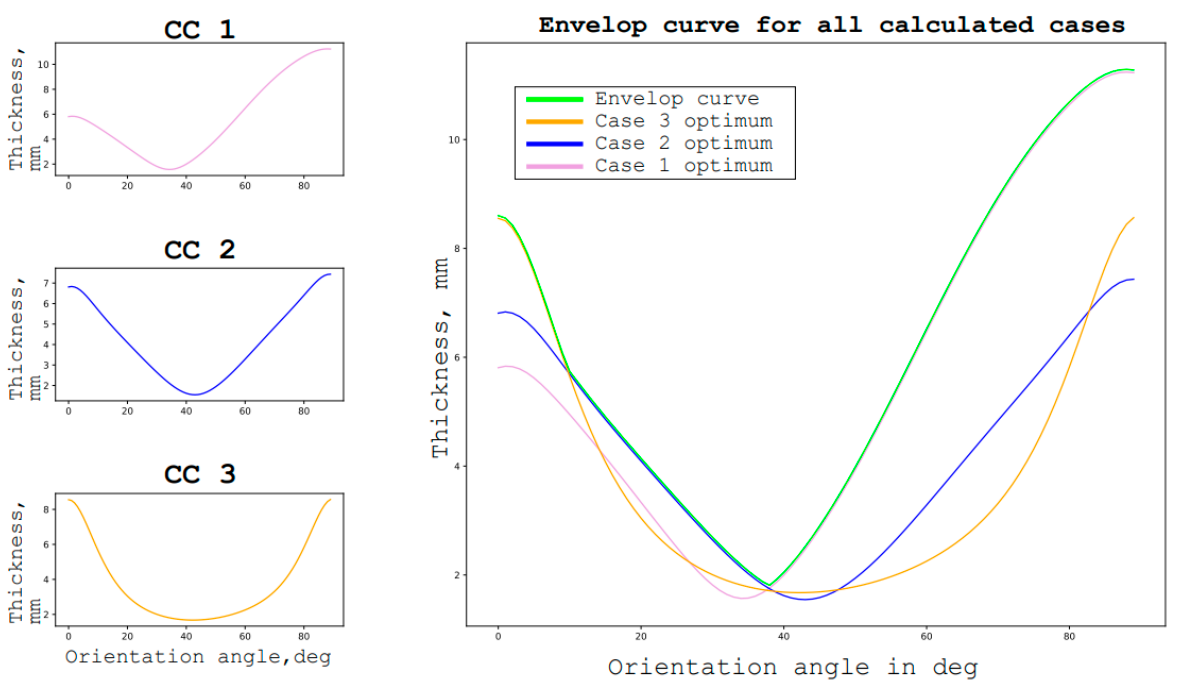
Figure 6. Strength failure coefficients for the different layer orientations for various calculative cases for a specific case study.